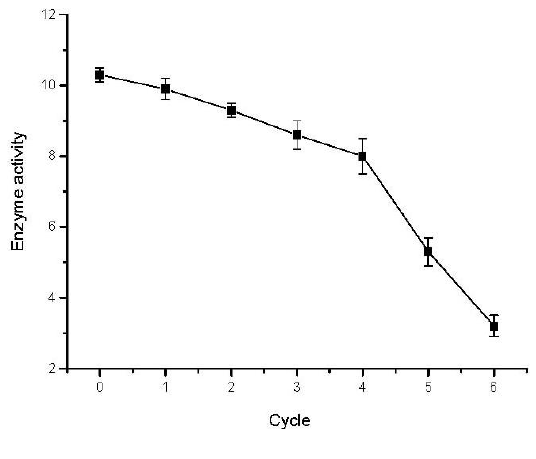
Figure 4. Oxidative coupling of trans-resveratrol in repeated batch process by immobilized